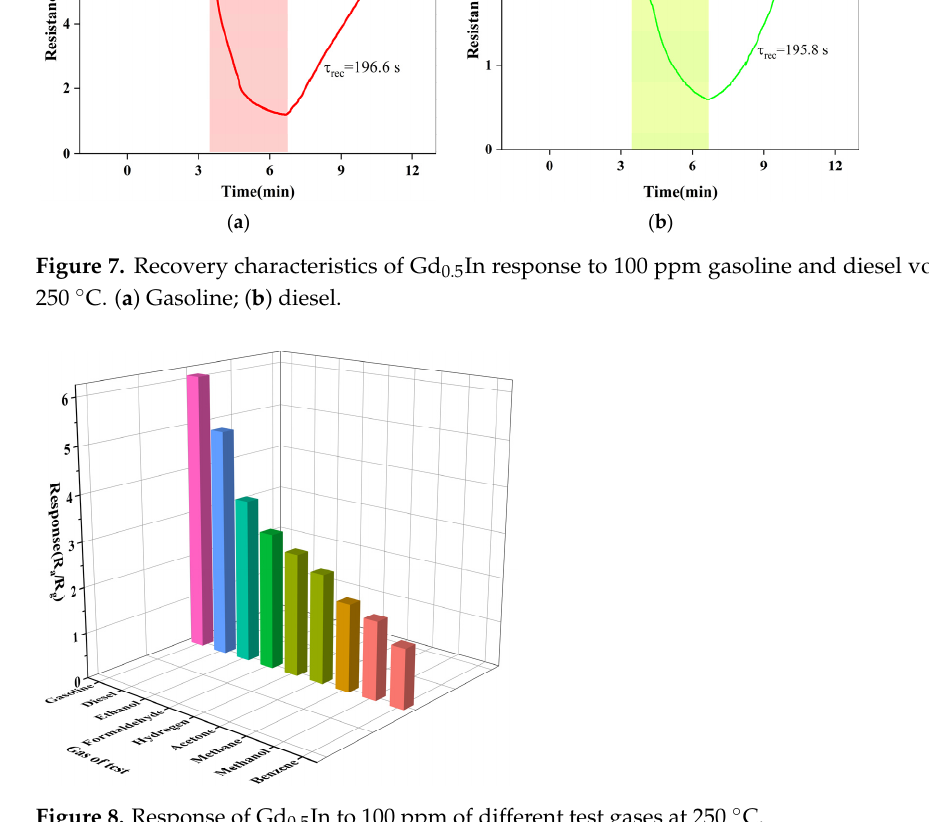
0.5 In to 100 ppm of different test gases at 250